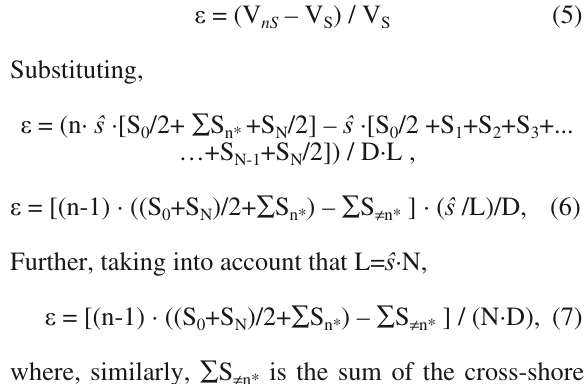
Fig . 3. – Sketch showing N+1 cross-shore profiles (P …., P ) with a spacing of ŝ . Net areas between profiles of different N bathymetries are designated S level (LLWL) is the elevation reference or datum. Virtual beach width displacement ( ∆ B), berm height (z) and closure depth (h*)